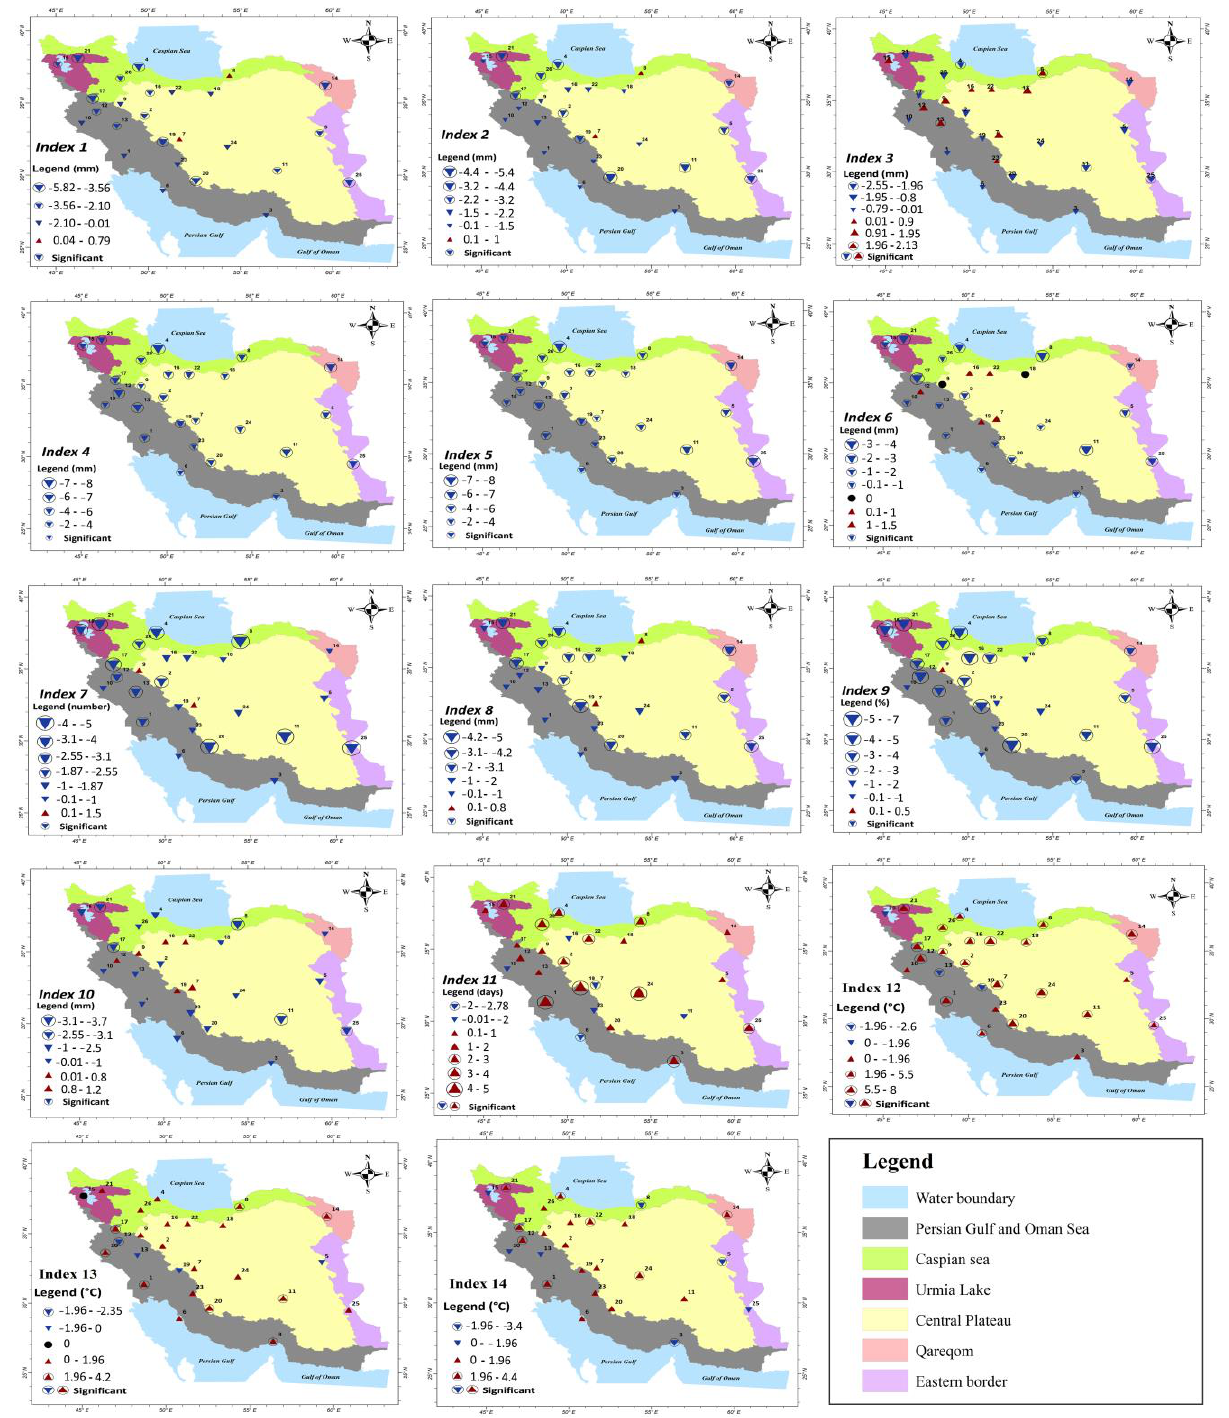
Figure 3. Spatiotemporal trend of the selected extreme precipitation and air temperature indices over Iran.